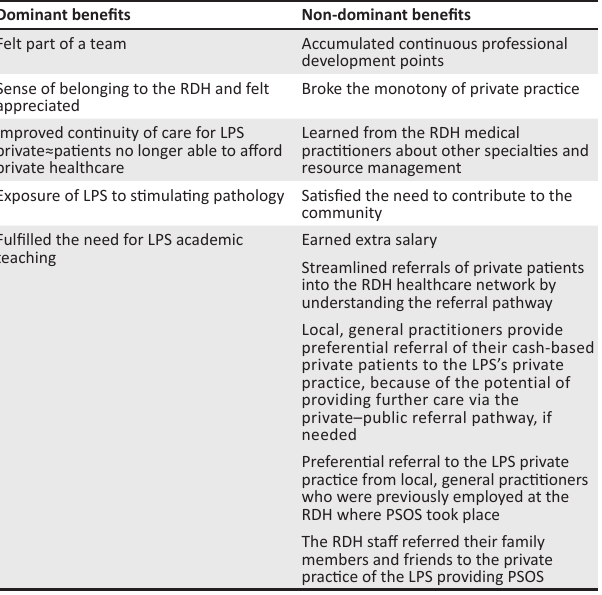
TABLE 5: Dominant and non-dominant benefits of private specialist outreach and support to local, private specialists. Dominant